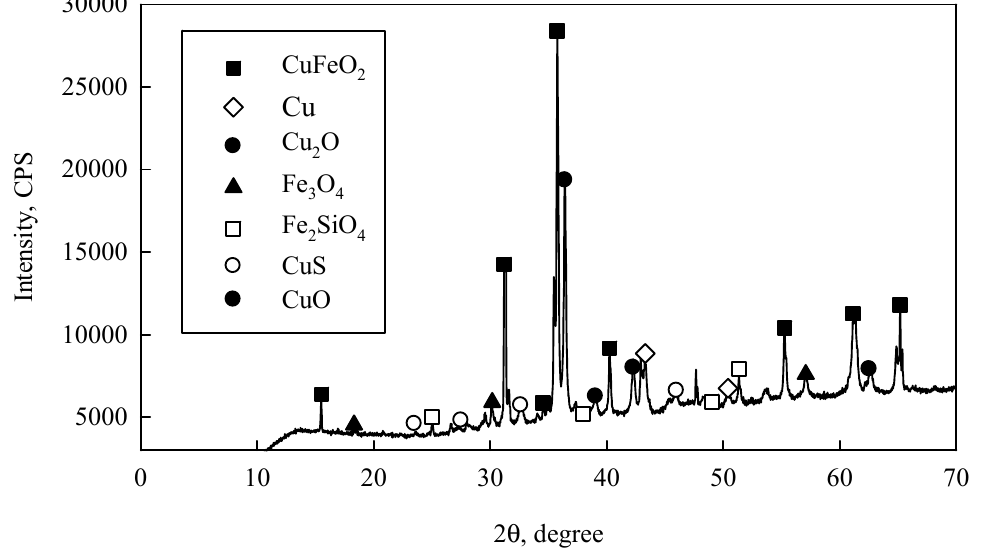
Figure 1. X-ray di ff raction (XRD) of original converter slag Figure 1. X-ray diffraction (XRD) of original converter slag sample.